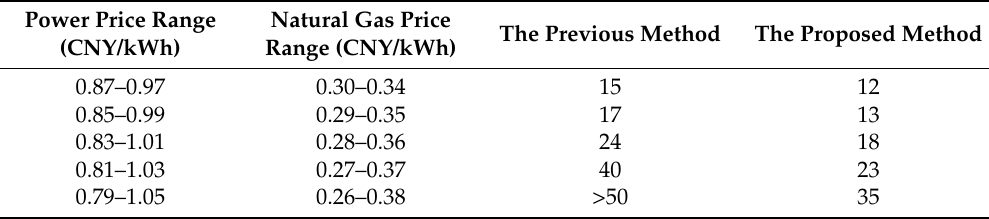
Table 8. Comparison of fluctuation result for input energy